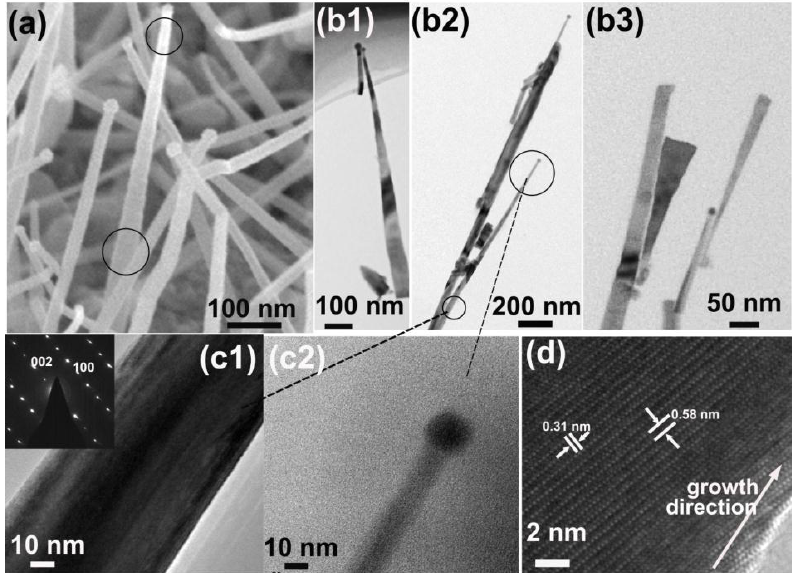
Figure 7. ( a ) Enlarged SEM image of the nanowires with small lateral size. ( b1 – 3 ) TEM images of these nanowires. ( c1 – 2 ) Enlarged TEM images of the marked places of a nanowire in Figure 2b. The inset in ( c1 ) is the SAED pattern. ( d ) High-resolution TEM image of the